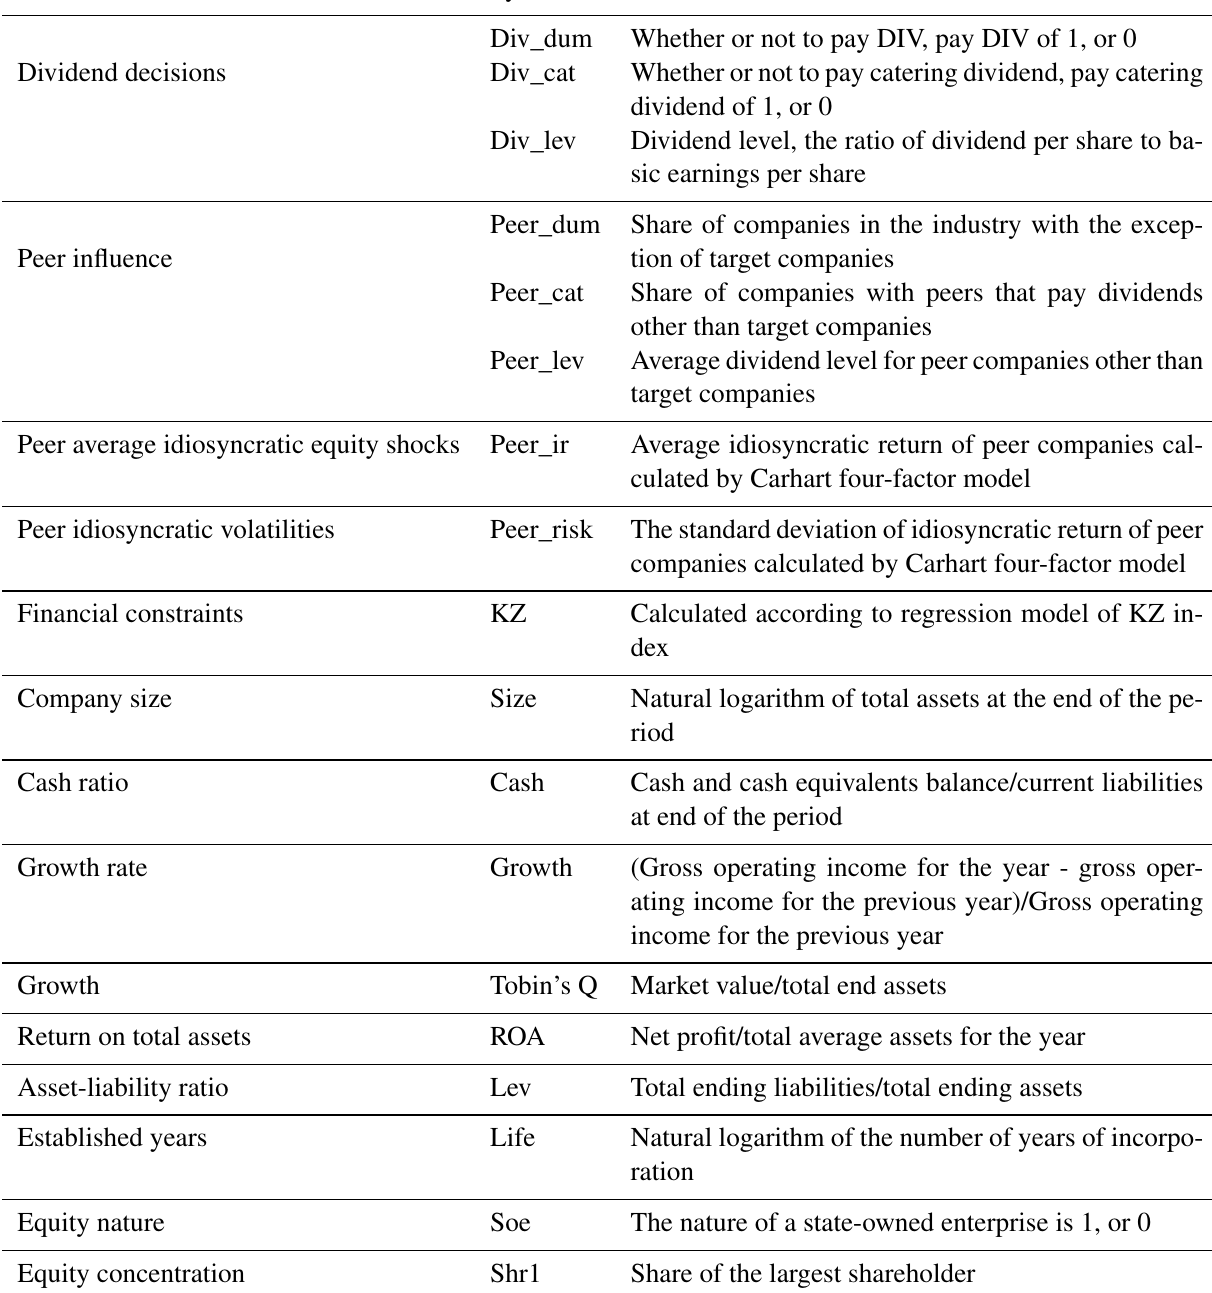
Table 2 Variable